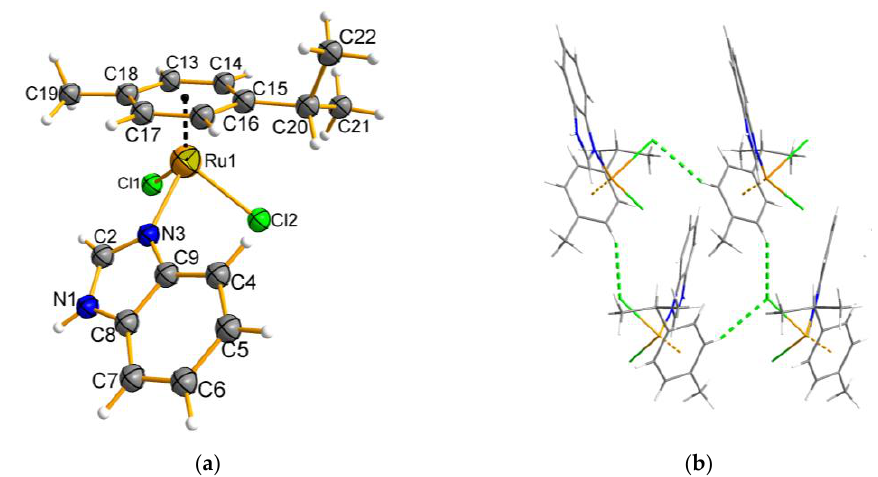
Figure 2. Molecular structure of complex 2 ( a ). Crystal packing with marked supramolecular interactions of C – H···Cl types constructing tetramer (view along c axis) ( b ).